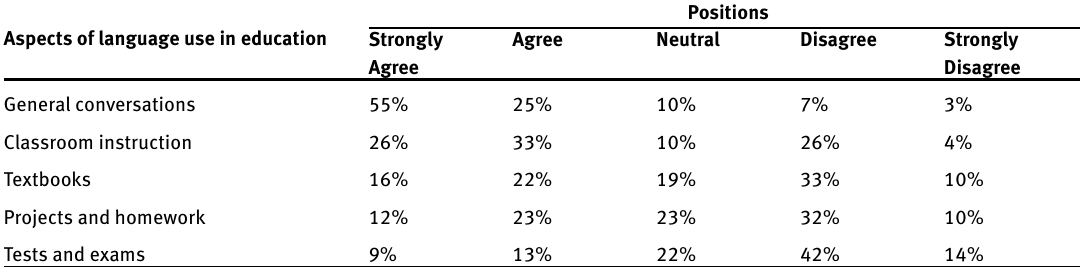
Table 4. Position towards language use in